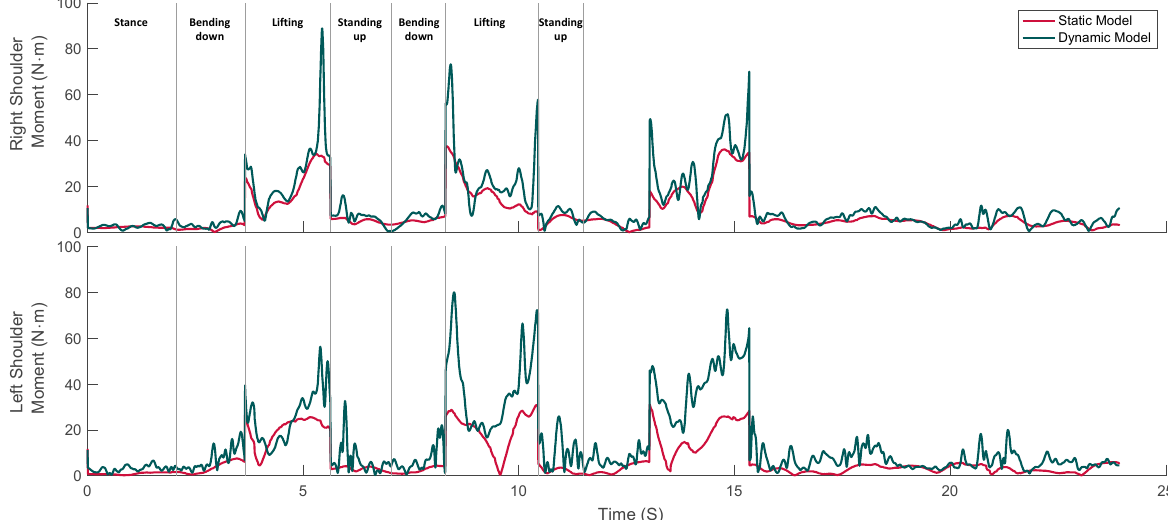
Figure 11. Typical examples of predicted right and left shoulder joint moments by the static (red lines) and dynamic (dark-green lines) models during lifting.